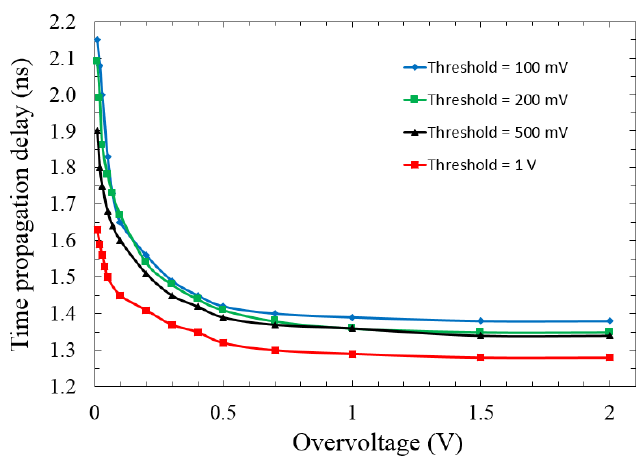
Figure 10. QC time propagation as a function of the overvoltage. The overvoltage corresponds to the input applied voltage minus the